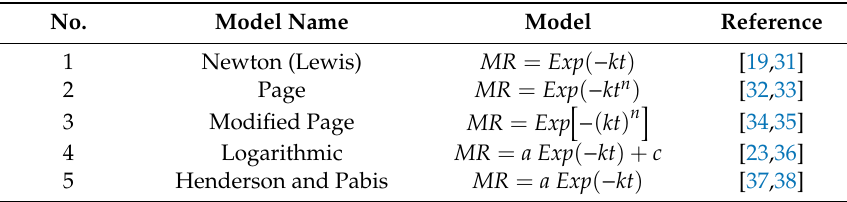
Table 2. Thin-layer empirical models considered in this